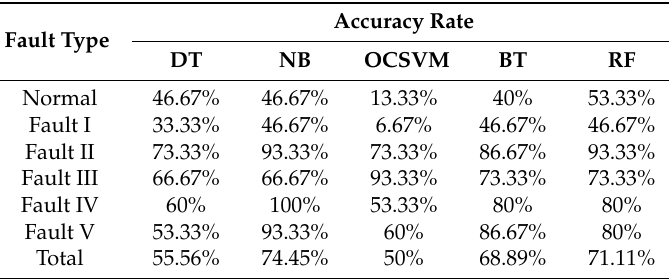
Table 5. WTFER-based diagnosis results. Table 5. WTFE-based diagnosis results.